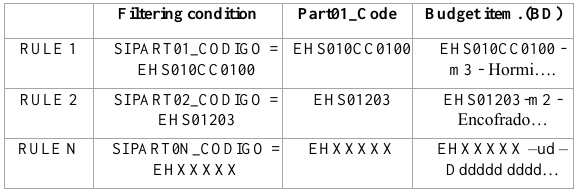
Table 1. Rules established for the relationship of the IFC Code parameter and Budgetary BD.